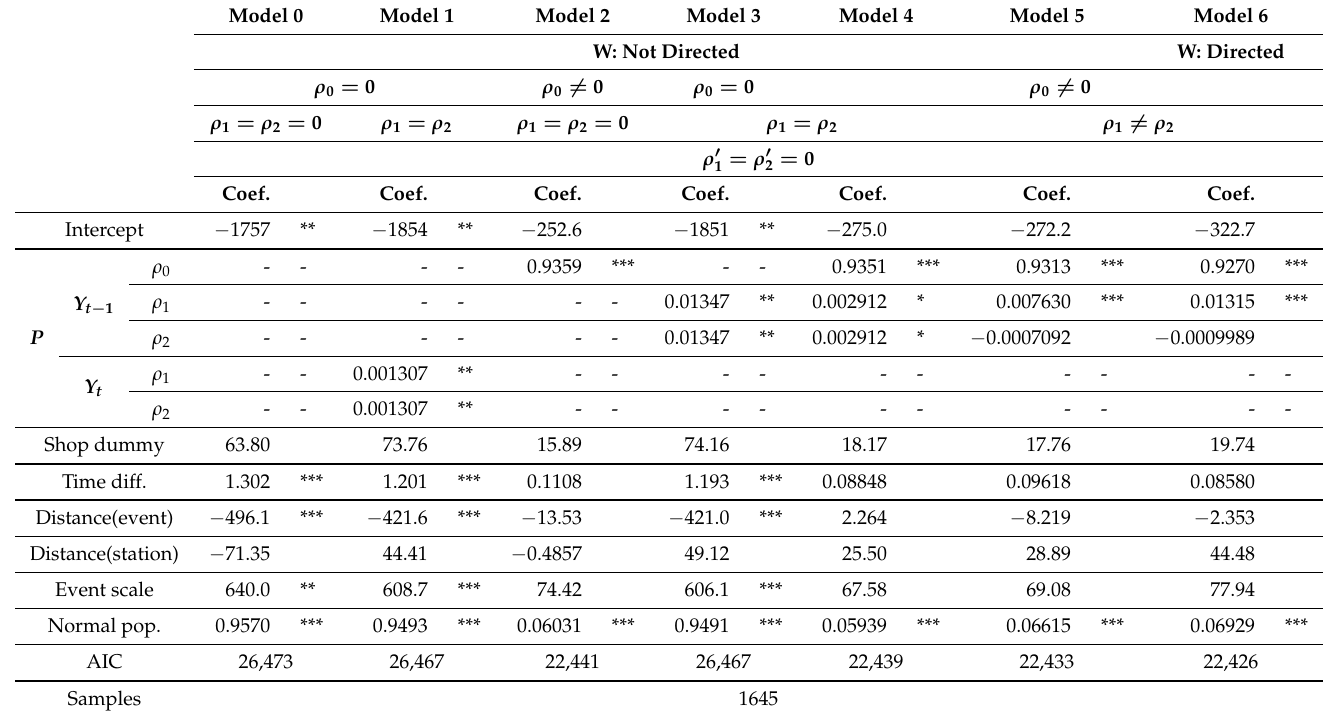
Table 4. Results of models (using data before event